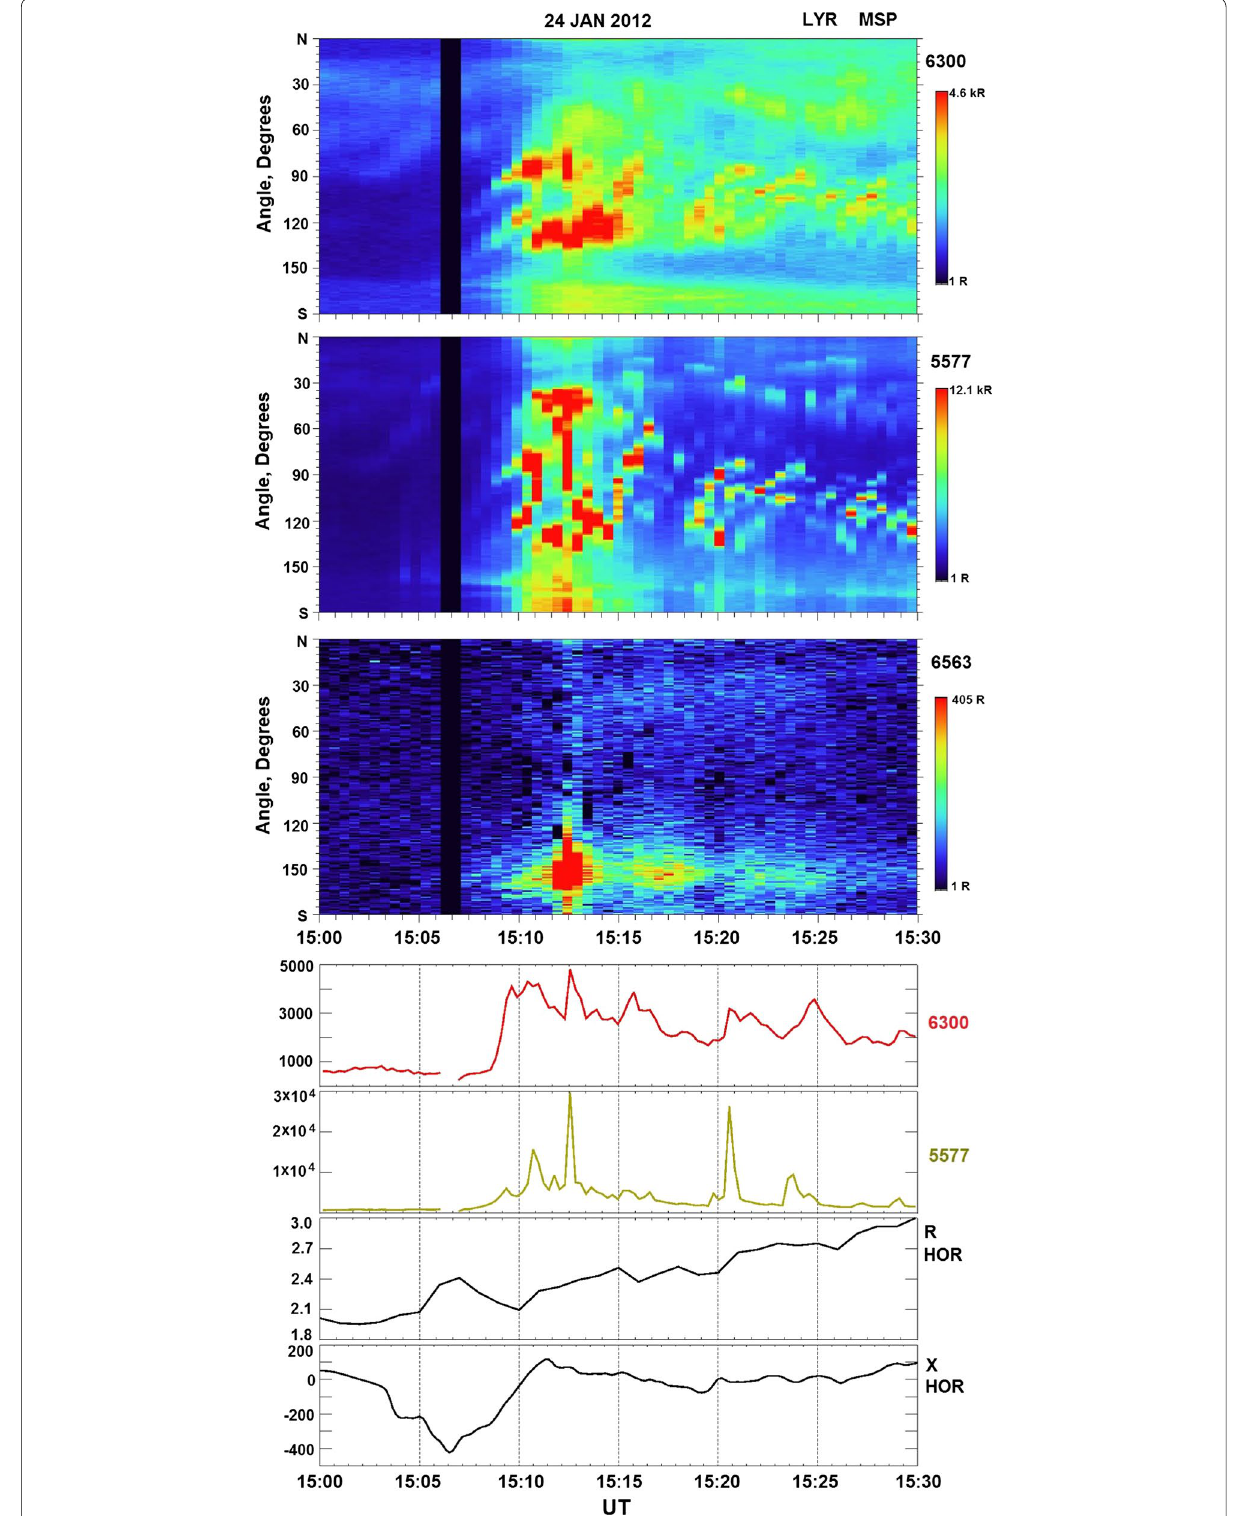
Fig. 10 Keograms of 630.0, 557.7, and 6563 nm emissions recorded by meridian scanning photometer at LYR ( upper panels ), vertical intensities of 630.0 nm and 557.7 nm emissions (in Rayleigh), riometer variations (in dB), and geomagnetic variations (X-component) (in nT) at station HOR